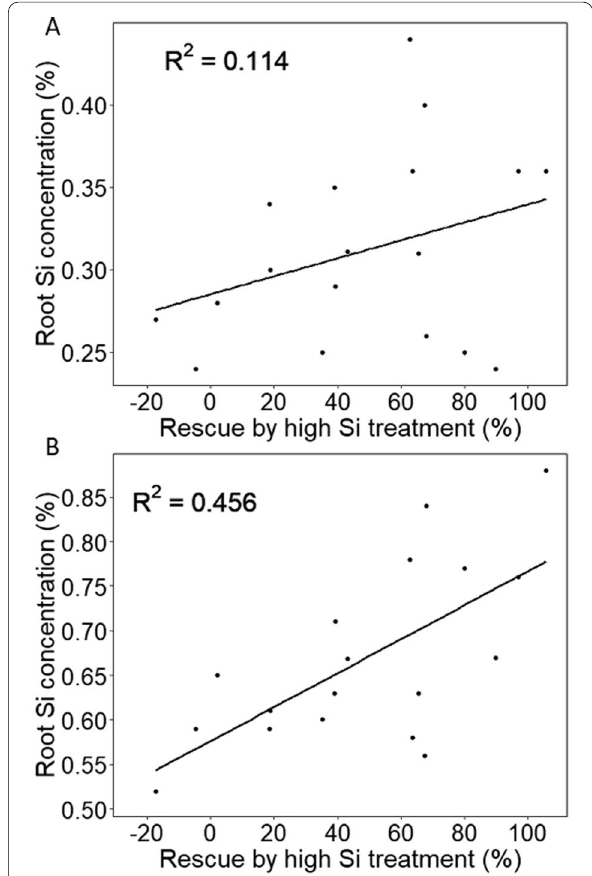
Fig. 2 The mitigating effect of Si (% Rescue; defined as biomass in high Si plus salt condition relative to low Si plus salt condition) significantly correlates with root Si ( a ) but more so in high Si conditions ( b )